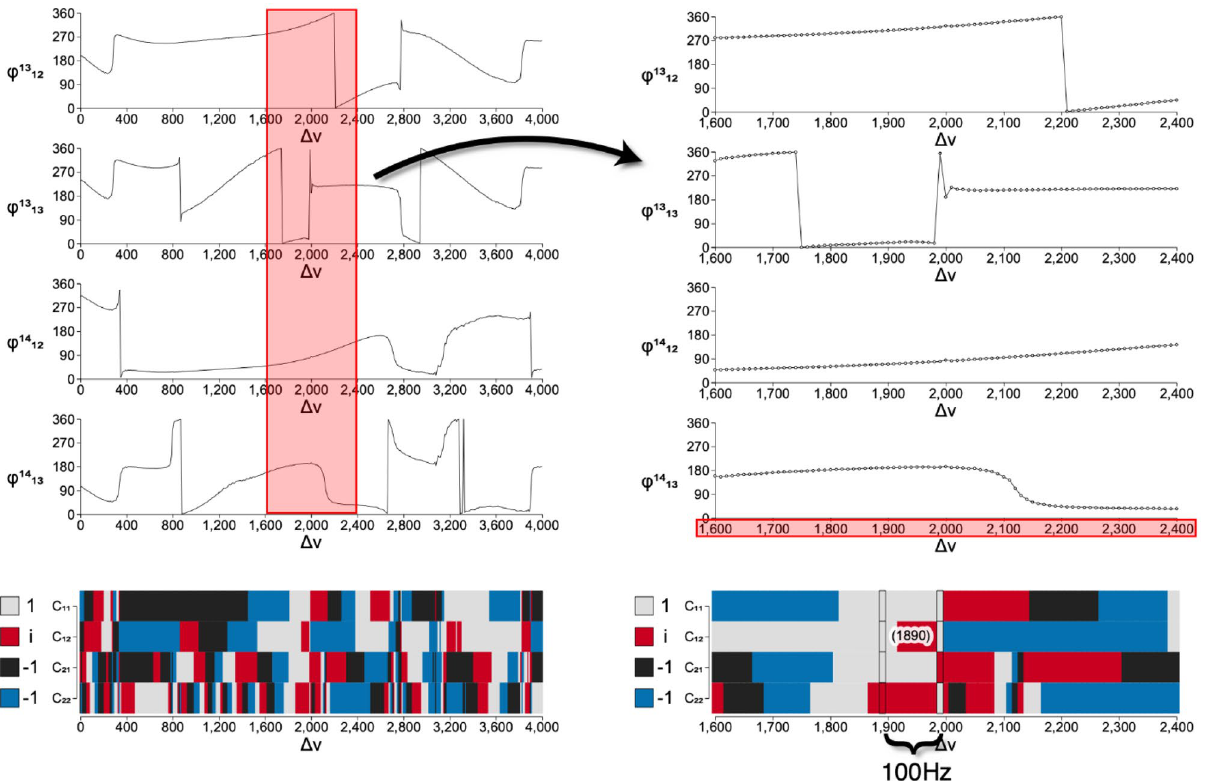
Figure 1. Analyzing two level states of logical phi-bits. Example of measured variations of the relative phases ϕ i 12 and ϕ i 13 for phi-bits i = 13, 14 are shown on the top left. The phases are in degrees, and the tuning parameter �ν is in Hz. On the top right figure we focus on a region between 1.6 and 2.4 kHz. The bottom figures visualize the four color encoded values of the four components of our two phi-bit representation over the entire range of tuning parameter (bottom left) and the focused region (bottom right) where the C-NOT operation is illustrated (see text for